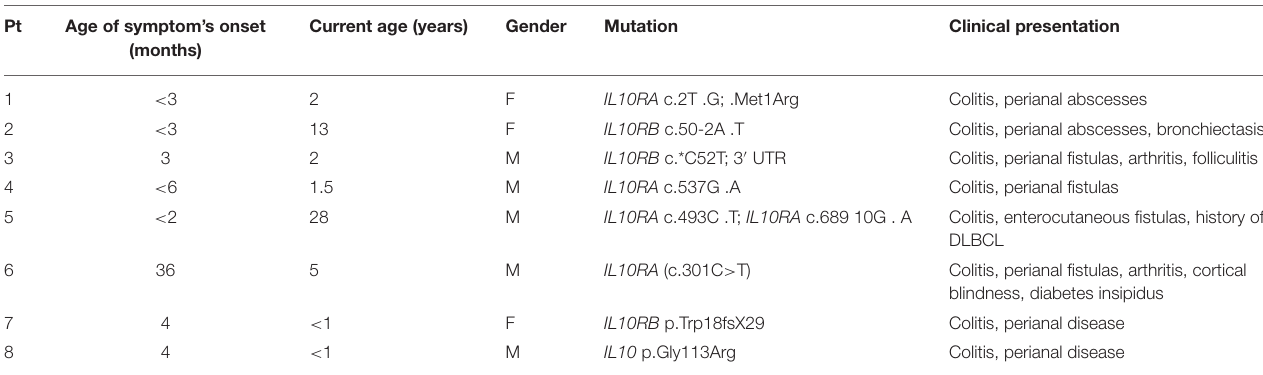
TABLE 1 | Clinical and genetic characteristics of the patients. Pt Age of symptom’s onset Current age (years) Gender Mutation Clinical (months)